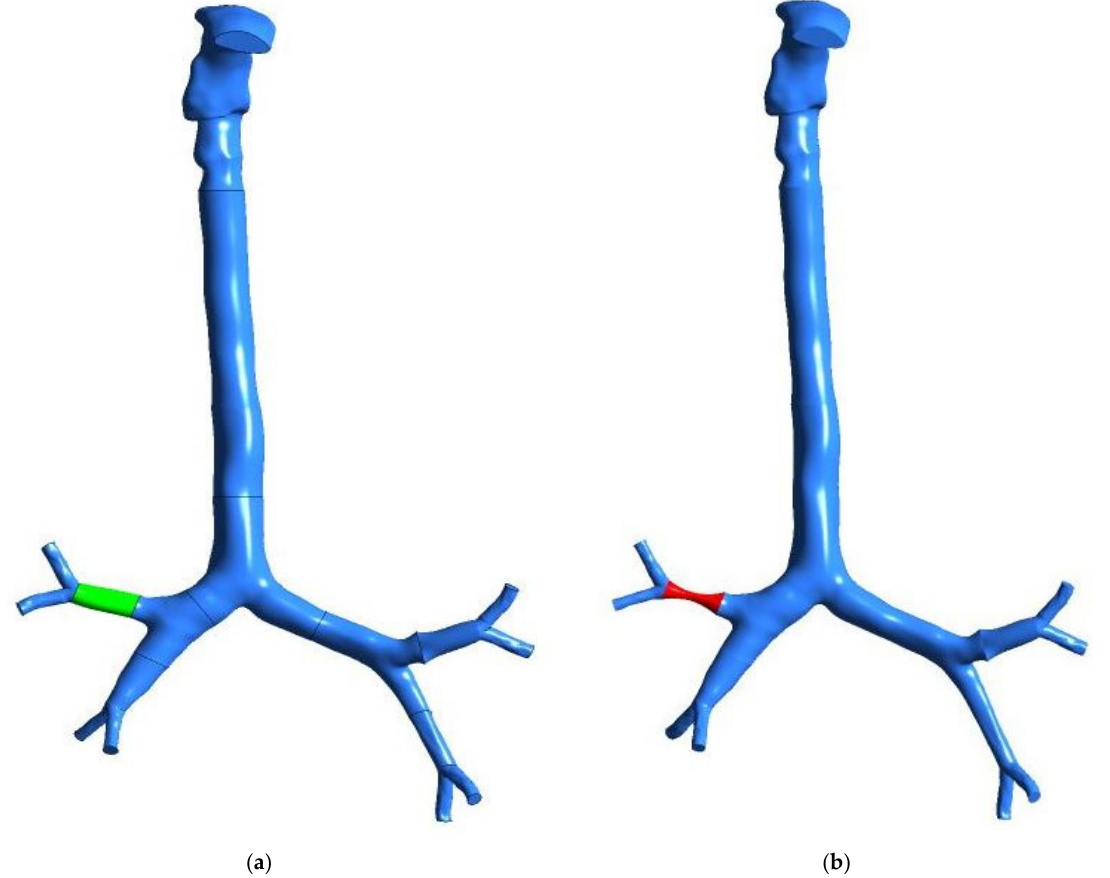
Figure 13. Reconstructed models of the mouth–throat and tracheobronchial airways: ( a ) healthy lung model, ( b ) stenosis lung model.